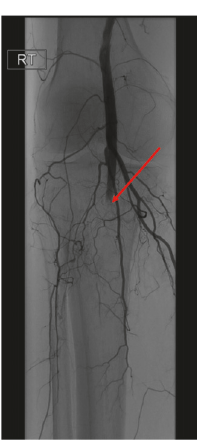
Figure 3: Right lower extremity angiogram demonstrating acute occlusion of the distal popliteal artery with no significant runoff vessels. A catheter was placed in this artery and Tissue Plasminogen Activator (TPA) was infused overnight. Subsequent evaluation revealed resolution of thrombus within the popliteal artery and tibioperoneal